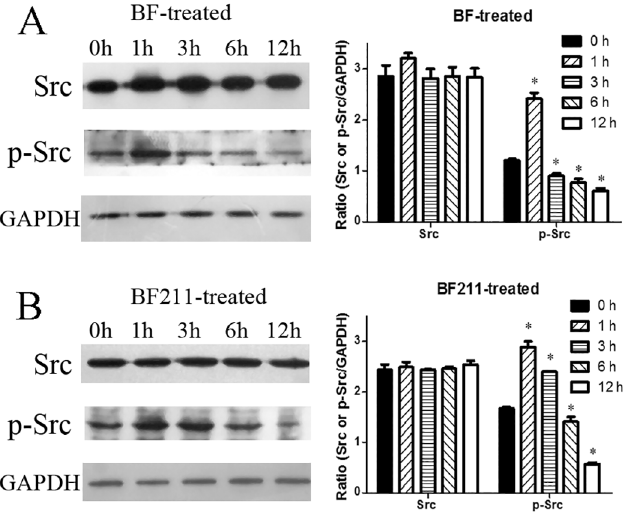
Fig 5. Effects of BF or BF211 on activation of Src in A549 cells. (A) The time-dependent effects of BF on the activation of Src in A549 cells treated with 50 nM BF for different time periods. Both representative western blot assay results and quantification analysis results were shown. The quantification data are the statistical results (n = 3, mean ± SEM) of three independent experiments. * p < 0.05 vs. control (0 h group). (B) The time-dependent effects of BF211 on the activation of Src in A549 cells treated with 50 nM BF211 for different time periods. Both the representative western blot assay results and the quantification analysis results are shown. The quantification data comprise the statistical results (n = 3, mean ± SEM) of three independent experiments. * p < 0.05 vs. control (0 h